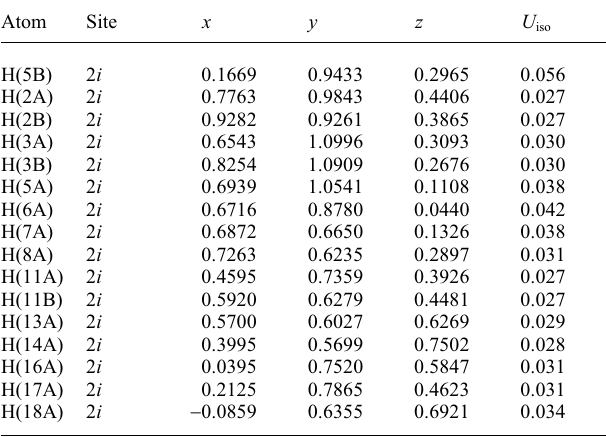
Table 2. Atomic coordinates and displacement parameters (in Å 2 )